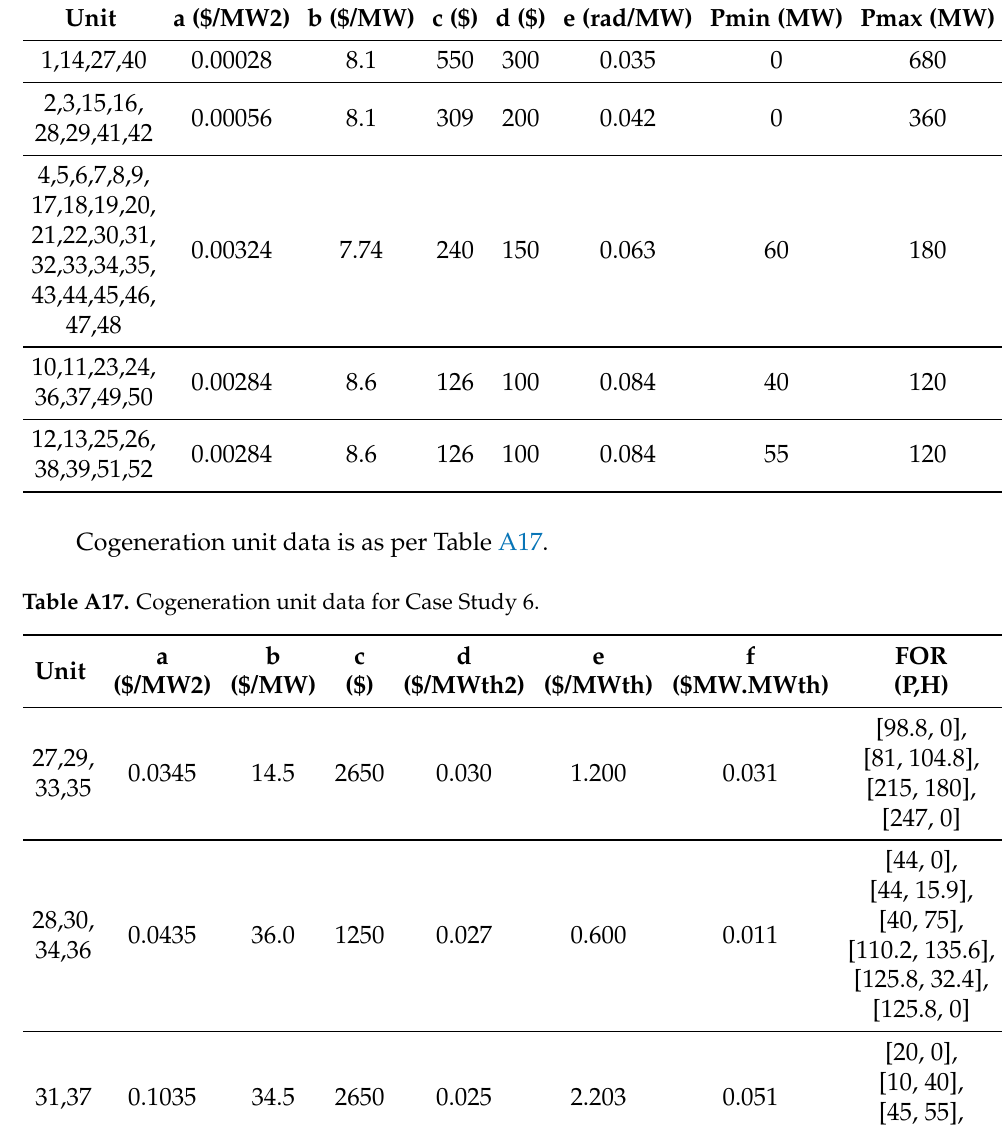
Table A16. Electrical Energy Generator unit data for Case Study 6.